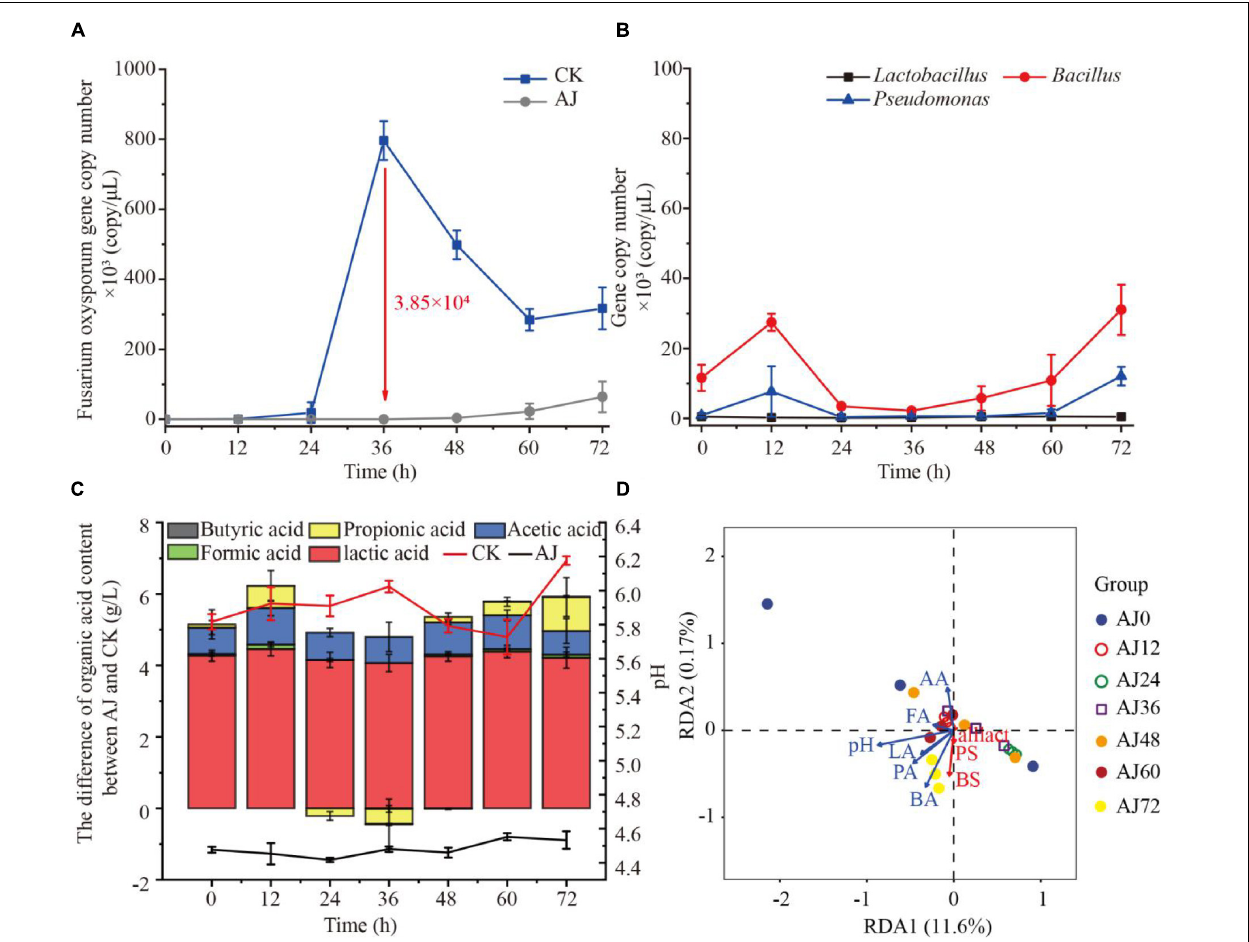
FIGURE 3 | Dynamic changes observed in microorganisms and physicochemical factors during the inhibition process. (A) Dynamic changes in Fusarium oxysporum gene copy number; (B) dynamic changes in Lactobacillus , Bacillus and Pseudomonas gene copy number during AJ treatment; (C) dynamic changes of pH and differences in organic acids content between AJ and CK; (D) redundancy analysis of physicochemical factors and beneficial microorganism in AJ treatment during the inhibition process. LA, lactic acid; FA, formic acid; AA, acetic acid; PA, propionic acid; BA, butyric acid; BS, Bacillus ; PS, Pseudomonas ; LS, Lactobacillus ; CK, without AJ treatment; AJ, with 10% AJ treatment. Data are mean ± standard deviation, n =